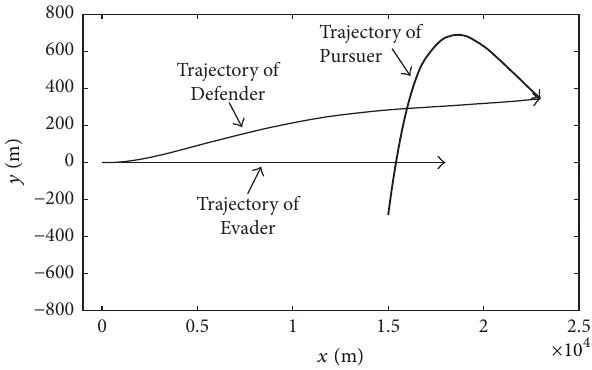
Figure 11: The trajectories of the noncooperative case considering HP guidance Pursuer.